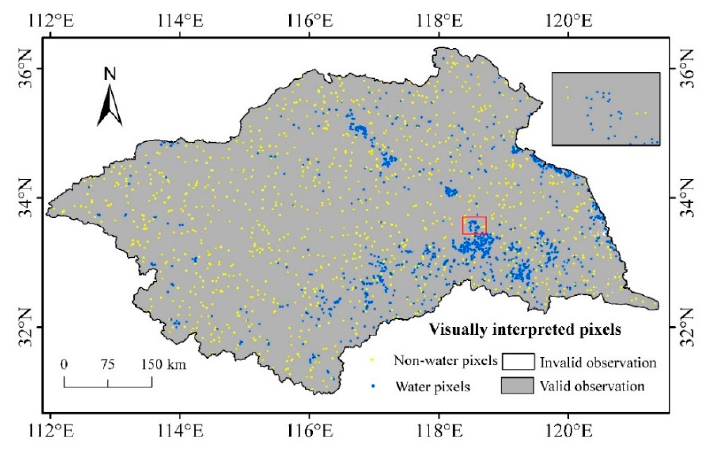
Figure 4. Visually interpreted water and non-water pixels.